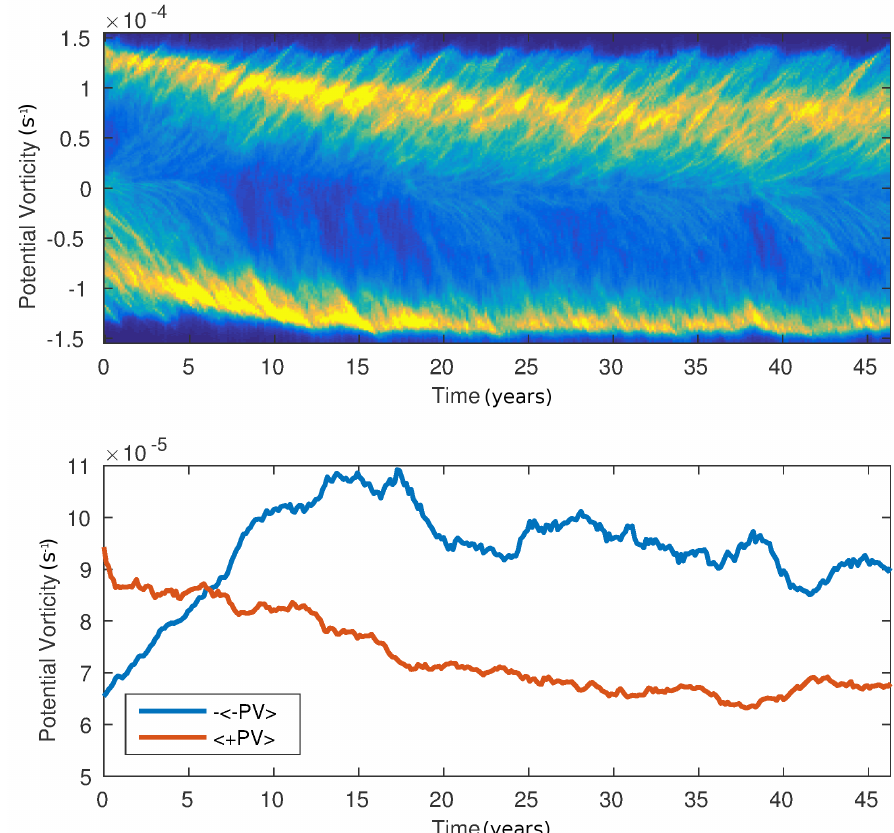
Figure 4. Hovmöller diagram of the global distribution of surface pseudo PV ( Q 1 ) from a simulation using Wind III , restarted from sign reversed and flipped initial condition. Temporal evolution of the distribution of potential vorticity ( up ) and of the mean positive and (minus) mean negative potential vorticity ( down